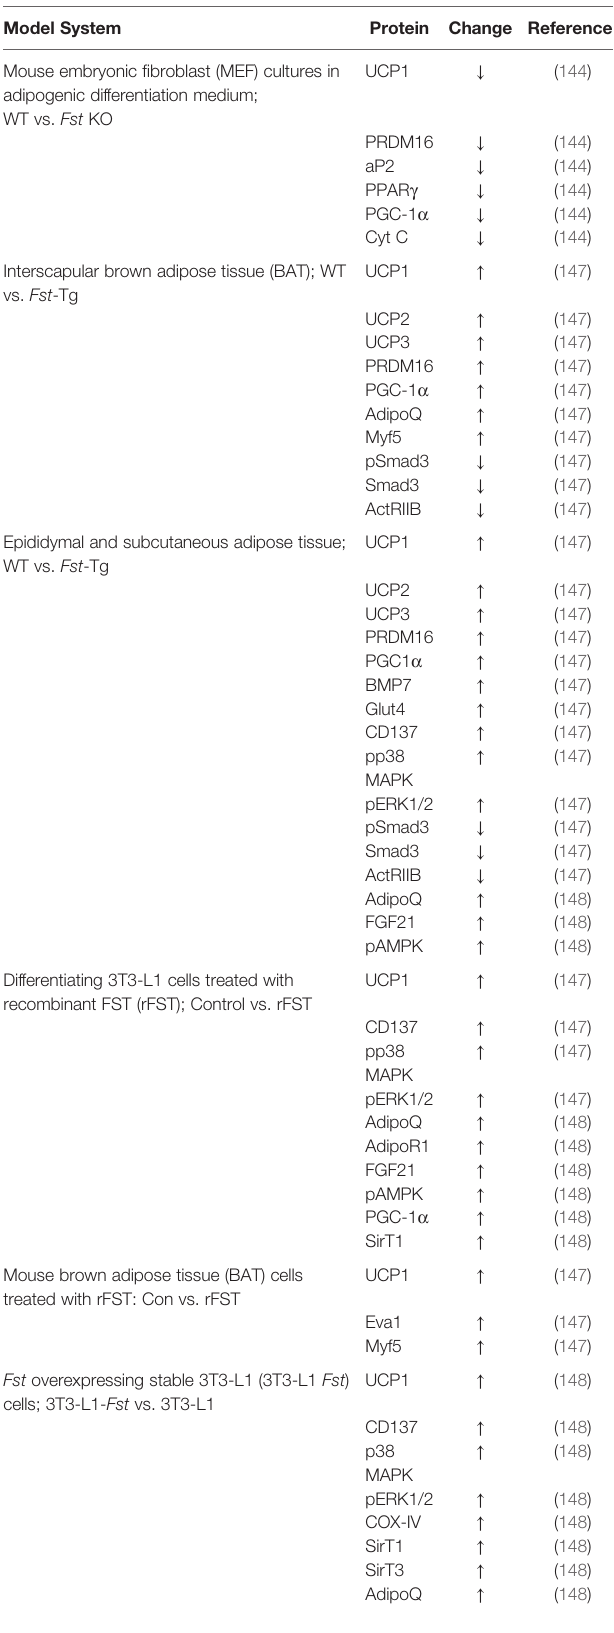
TABLE 1 | List of proteins targeted by